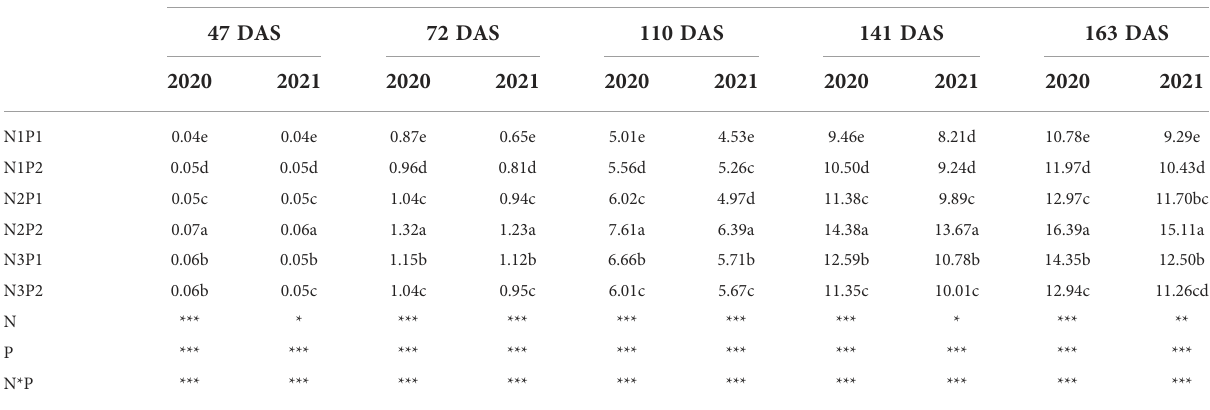
TABLE 3 Effects of different nitrogen and phosphorus combinations on dry biomass yield of sesbania pea at different growth stages in saline soils in 2020 and 2021.